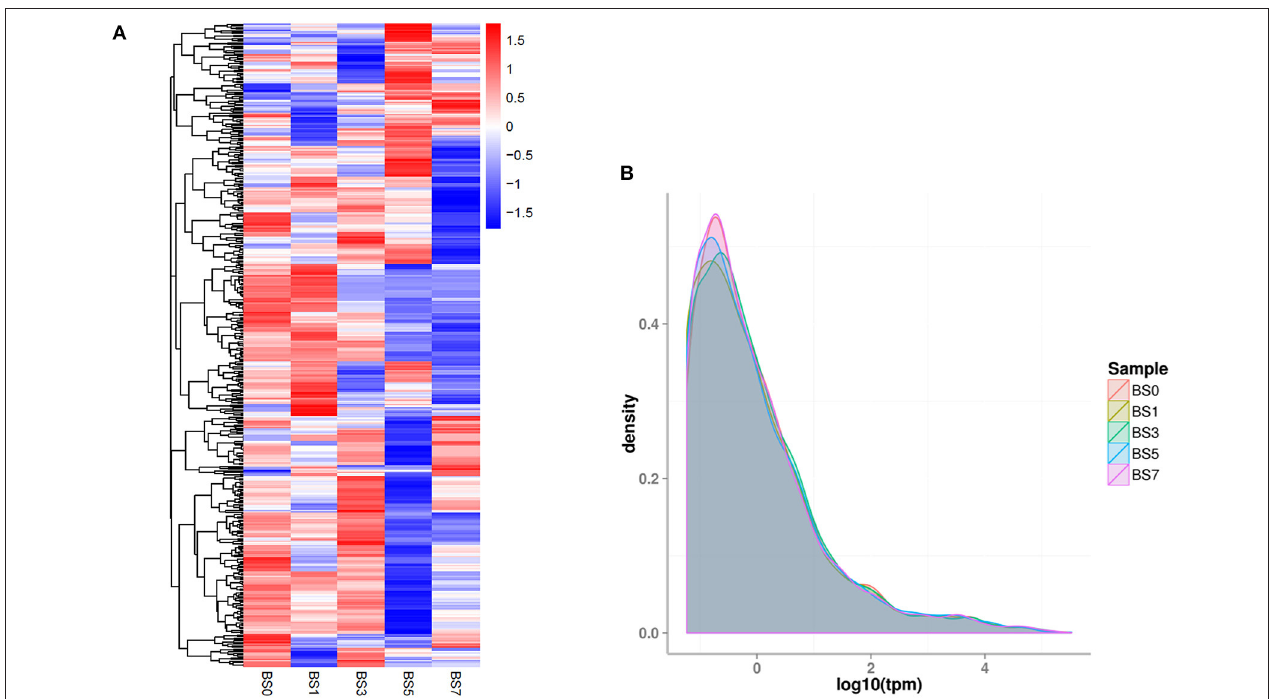
FIGURE 3 | The overall expression profiles of miRNA in each group. (A) The heatmap was based on the log TPM 2 of each miRNA. (B) The density distribution of miRNA expression level (TPM). Different colored curves represent different experimental samples.